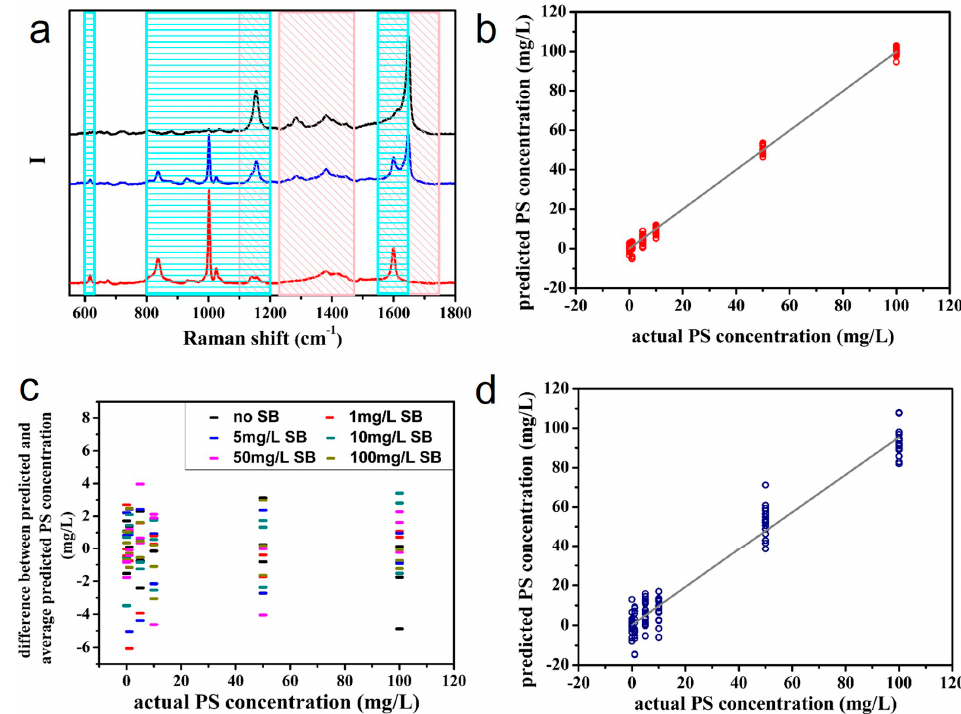
Figure 8. ( a ) The black, blue, and red lines represent the Raman spectra of PS solution, mixture solution containing PS and SB molecules, and SB solution measured with SERS substrates, respectively; the pink and blue rectangles mark the characteristic peaks of PS and SB that are employed to calibrate PLSR model; ( b ) PS concentration predicted by the PLSR model established with Raman spectra corresponding to PS characteristic peaks; ( c ) difference between predicted PS concentration of each mixture and average predicted PS concentration of solution with the same PS concentration; ( d ) PS concentration in the test solution with different compositions predicted by the PLSR model of PS (Reprinted with permission from [61]).